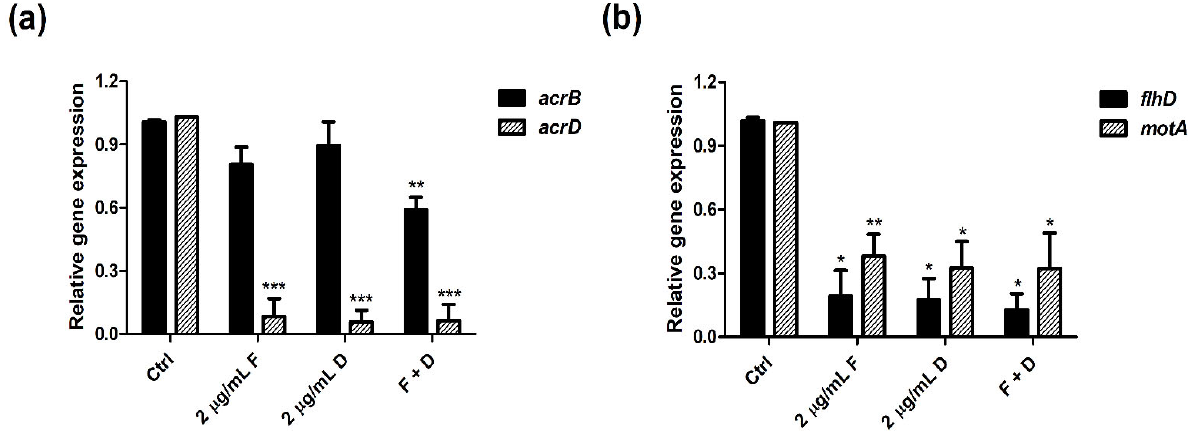
Figure 5. Transcriptional changes in virulence-related genes in E. coli . Expression levels of ( a ) efflux pump-related ( acrB , acrD ) genes and ( b ) motility-related ( flhD , motA ) genes are presented with a histogram. After treatment with fingolimod alone (2 µ g/mL F), doripenem alone (2 µ g/mL D), or the combination of 2 µ g/mL of doripenem and 2 µ g/mL of fingolimod (F + D), transcription levels of the target genes were normalized to that of 16S rRNA . Asterisks (*) indicate a significant decrease in expression levels in each gene (* p < 0.05 and ** p < 0.01, and *** p < 0.001).